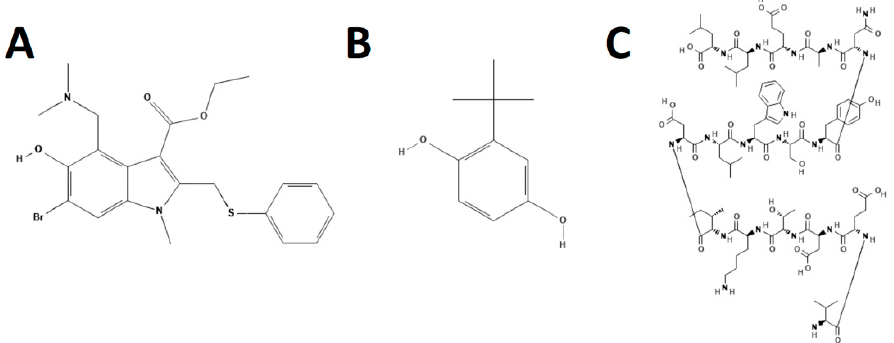
Figure 3. Structures of hemagglutinin fusion inhibitors. Umifenovir (Arbidol) ( A ), Tert-butyl hy- droquinone (TBHQ) ( B ), and Flufirvitide-3 ( C ). Structures were adapted from